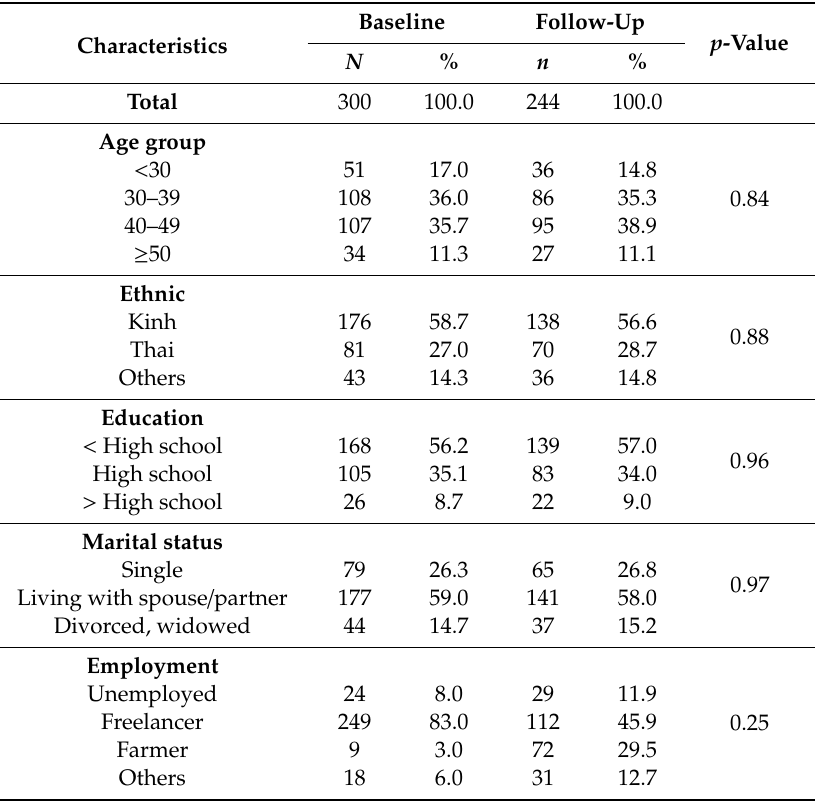
Table 1. Participant socio-demographic